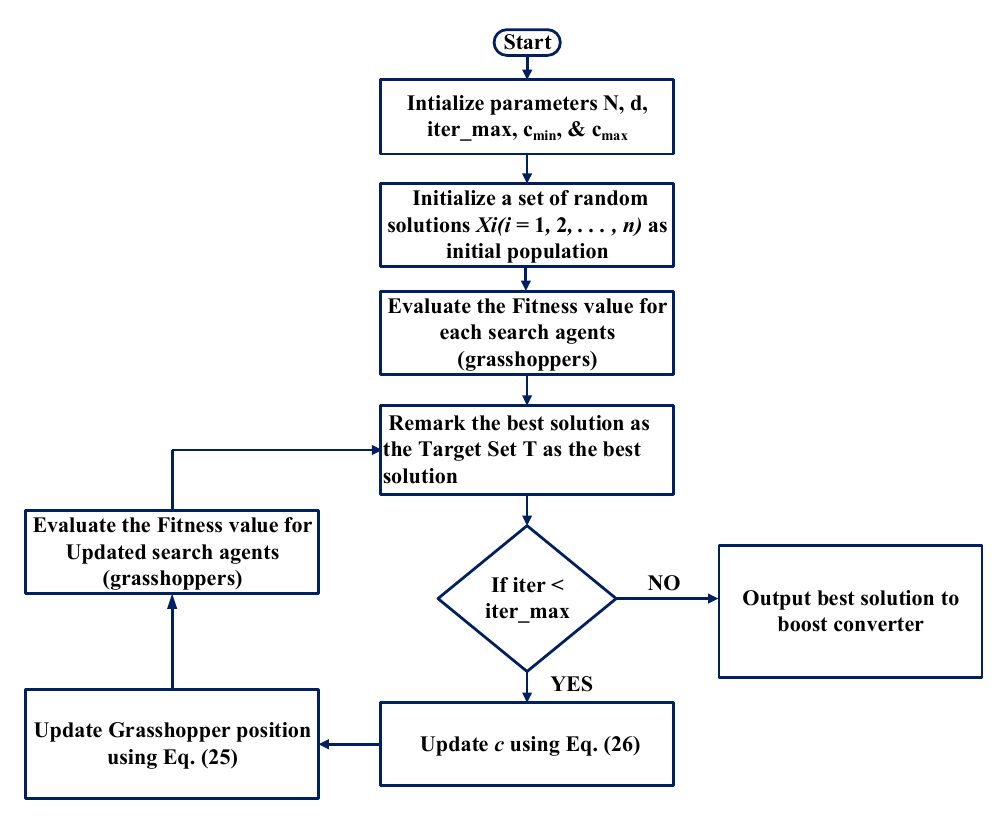
Figure 13. Flow chart of GO.